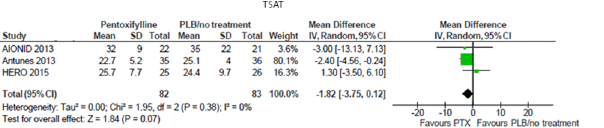
Fig 6. Effects of pentoxifylline vs. placebo/standard treatment on